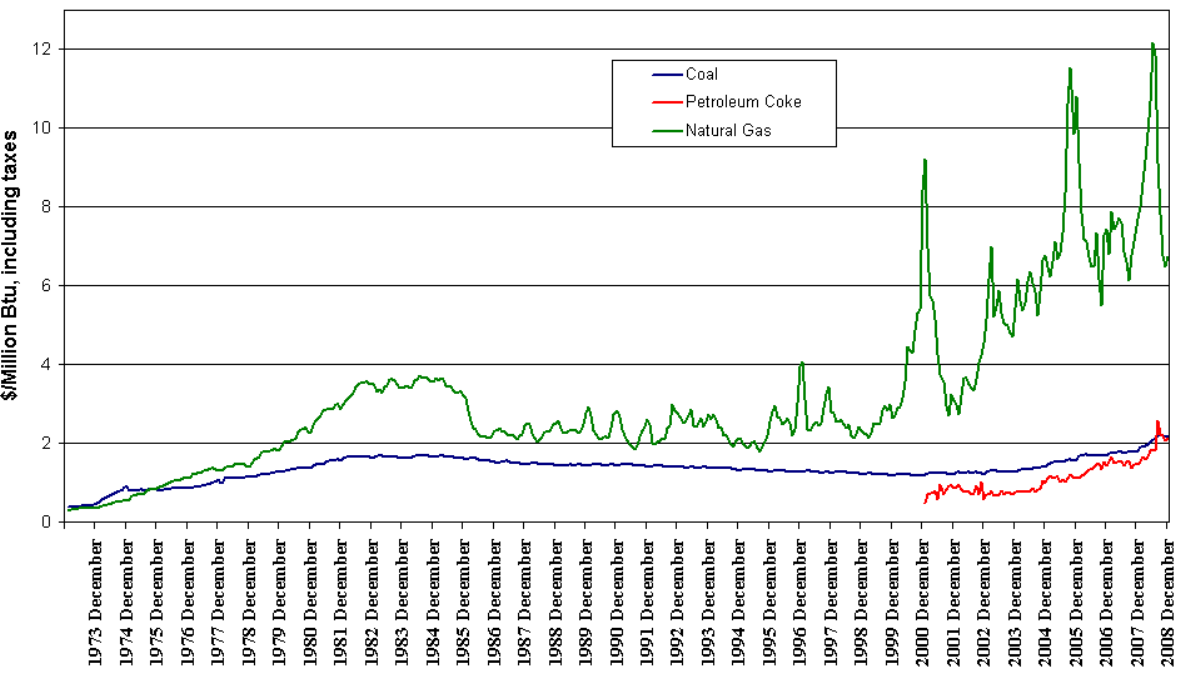
Figure 3. Cost of several fossil fuel inputs to electricity production in the U.S. Source: U.S.